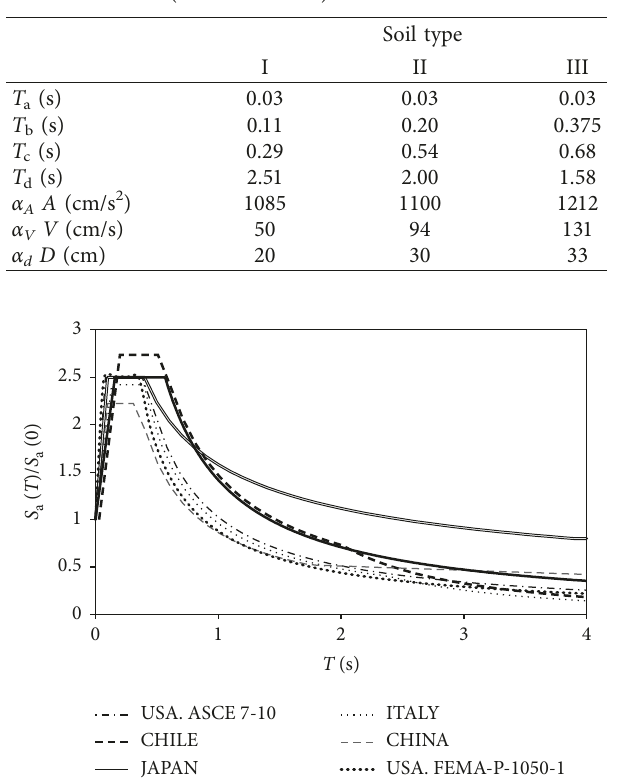
Table 11: Parameters for the generation of the design spectrum in the Chilean code (NCh 2745 2013).